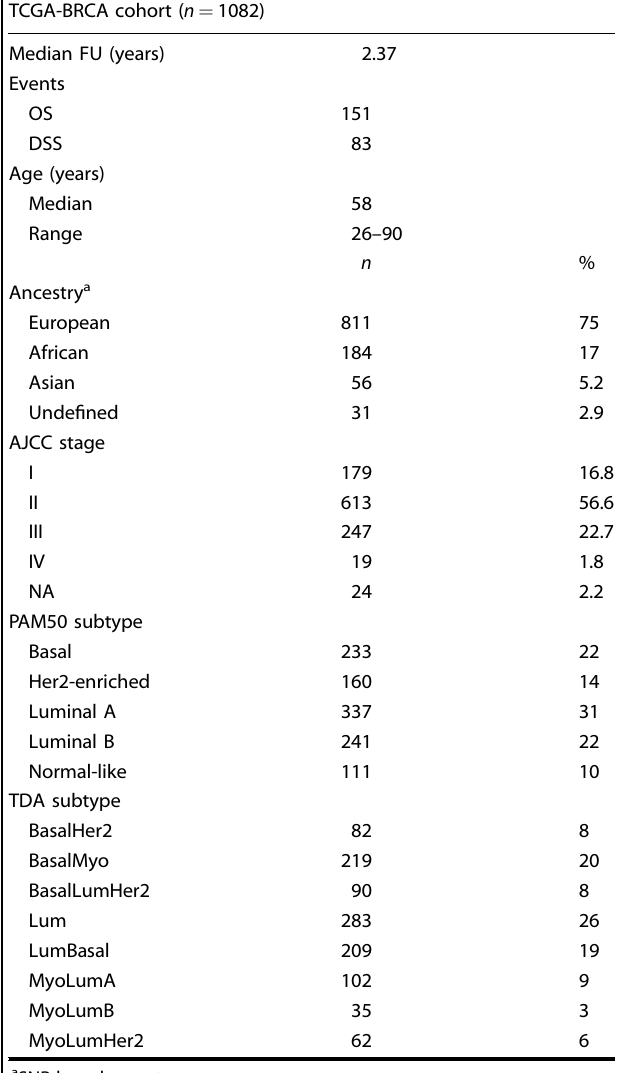
Table 1. Cohort demographics of the TCGA breast cancer